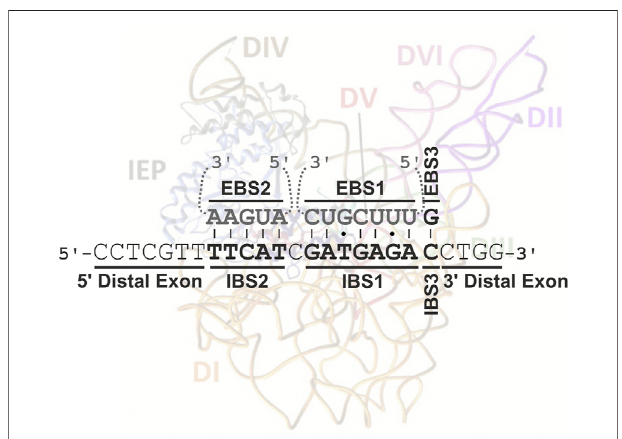
FIGURE 1 | Interaction between RmInt1 and its natural DNA target in ISRm2011-2. The intron binding sites (IBSs) in the DNA target (in bold) base- pair withthe exonbinding sites (EBSs) in theintron RNA(in gray).Thesebase- pairings extend from positions − 13 to +1 of the intron insertion site.